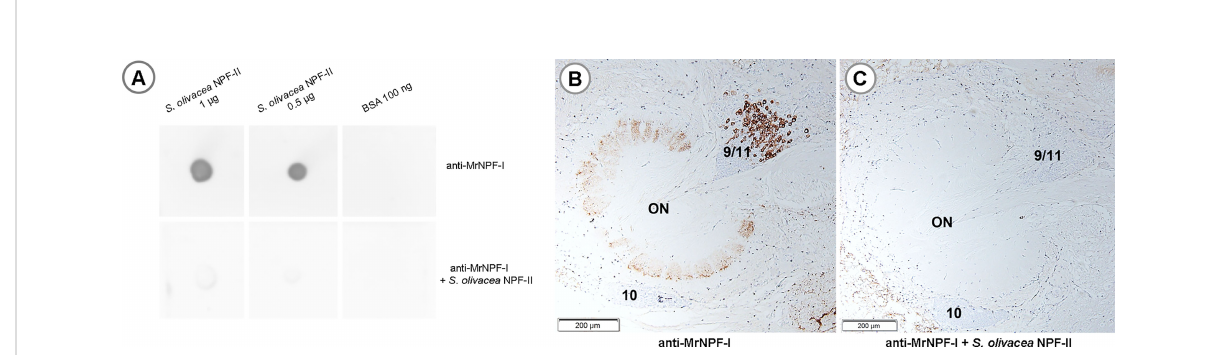
FIGURE 10 Speci fi city test of the anti- Macro NPF antibody to the Scyol- NPF II synthetic peptide. (A) In dot-blot analysis, cross-reactivity tests of the anti- Macro- NPF I antibody showed immunopositivity to Scyol- NPF II synthetic peptide. The pre-absorption of the anti- Macro -NPF I antibody and the synthetic Scyol- NPF II peptide did not show immunopositivity. (B) Immunohistochemistry analysis, the positive signal of Macro- NPF-ir was detected the neurons of cluster 9/11 and olfactory neuropil, (C) no detection in the section treated with preabsorbed